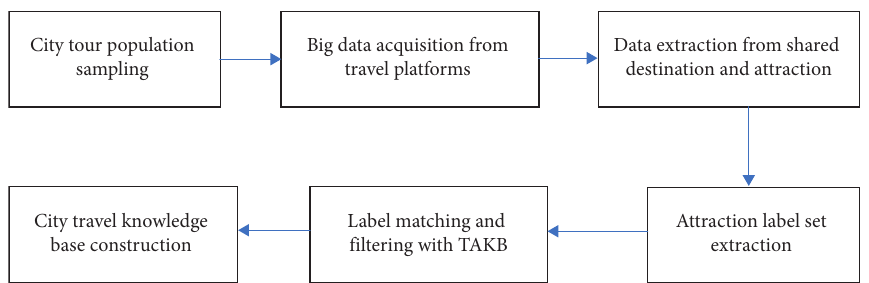
Figure 2: City travel knowledge data generating